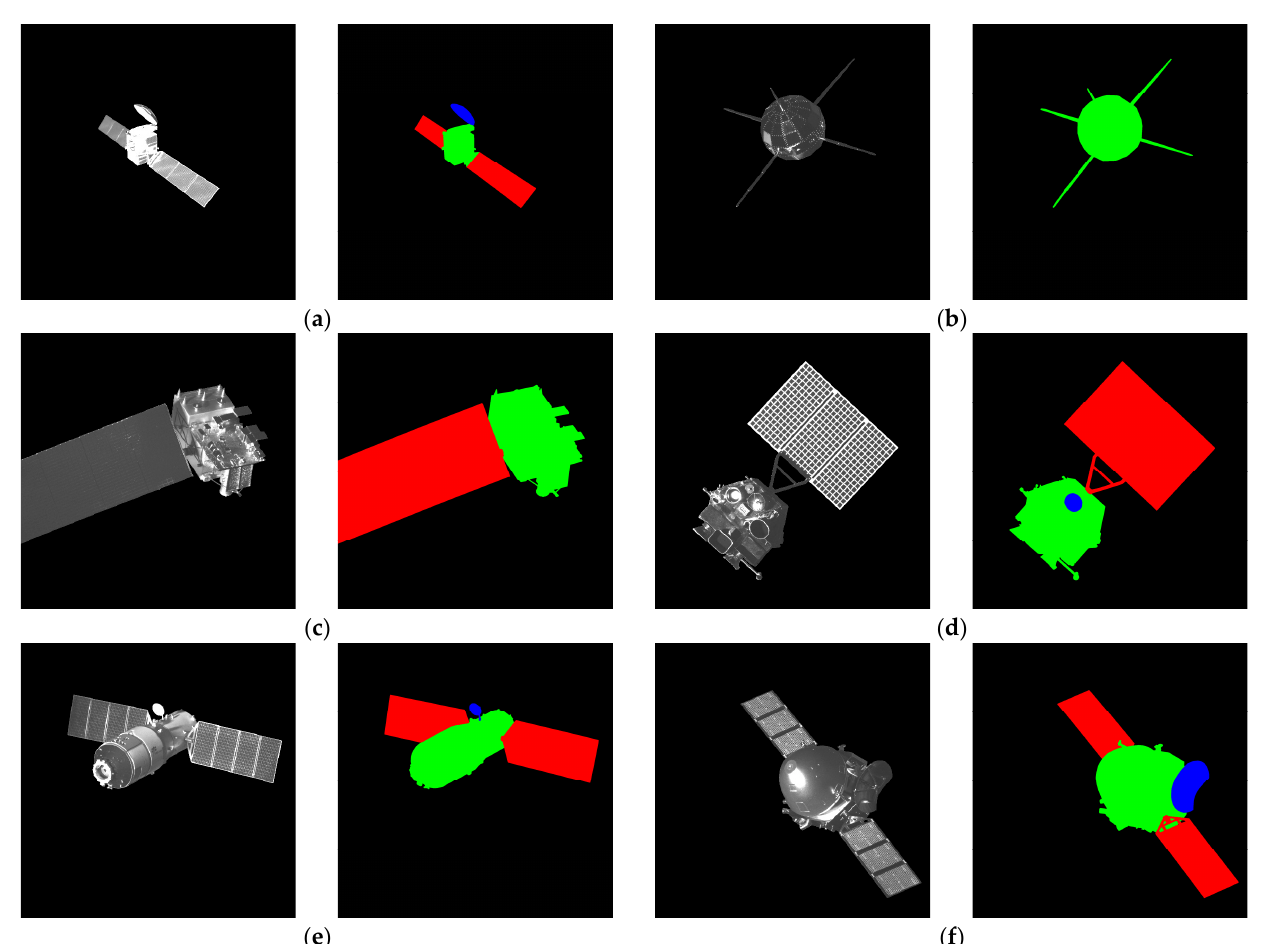
Figure 10. Images and labels of the real-shot validation dataset (red: solar panels; blue: antennae; green: body): ( a ) Beidou; ( b ) DFH; ( c ) FY-3; ( d ) FY-4; ( e ) TG; ( f ) TW.